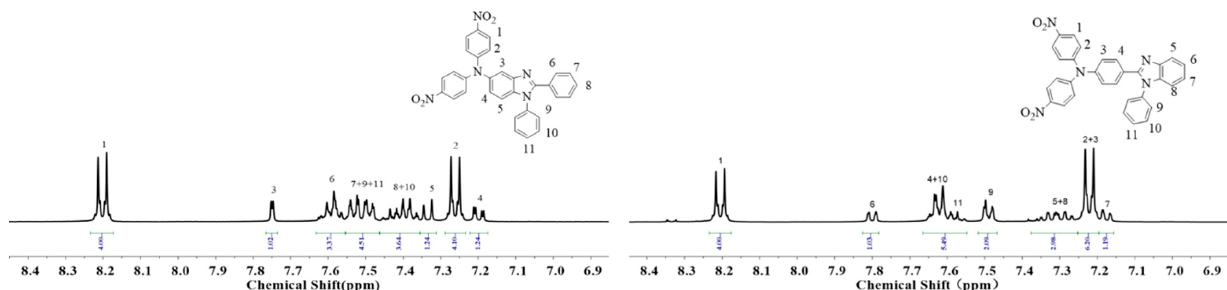
Figure 1. 1 H-NMR spectra of TPA-BIA-NO 2 and TPA-BIB-NO 2.